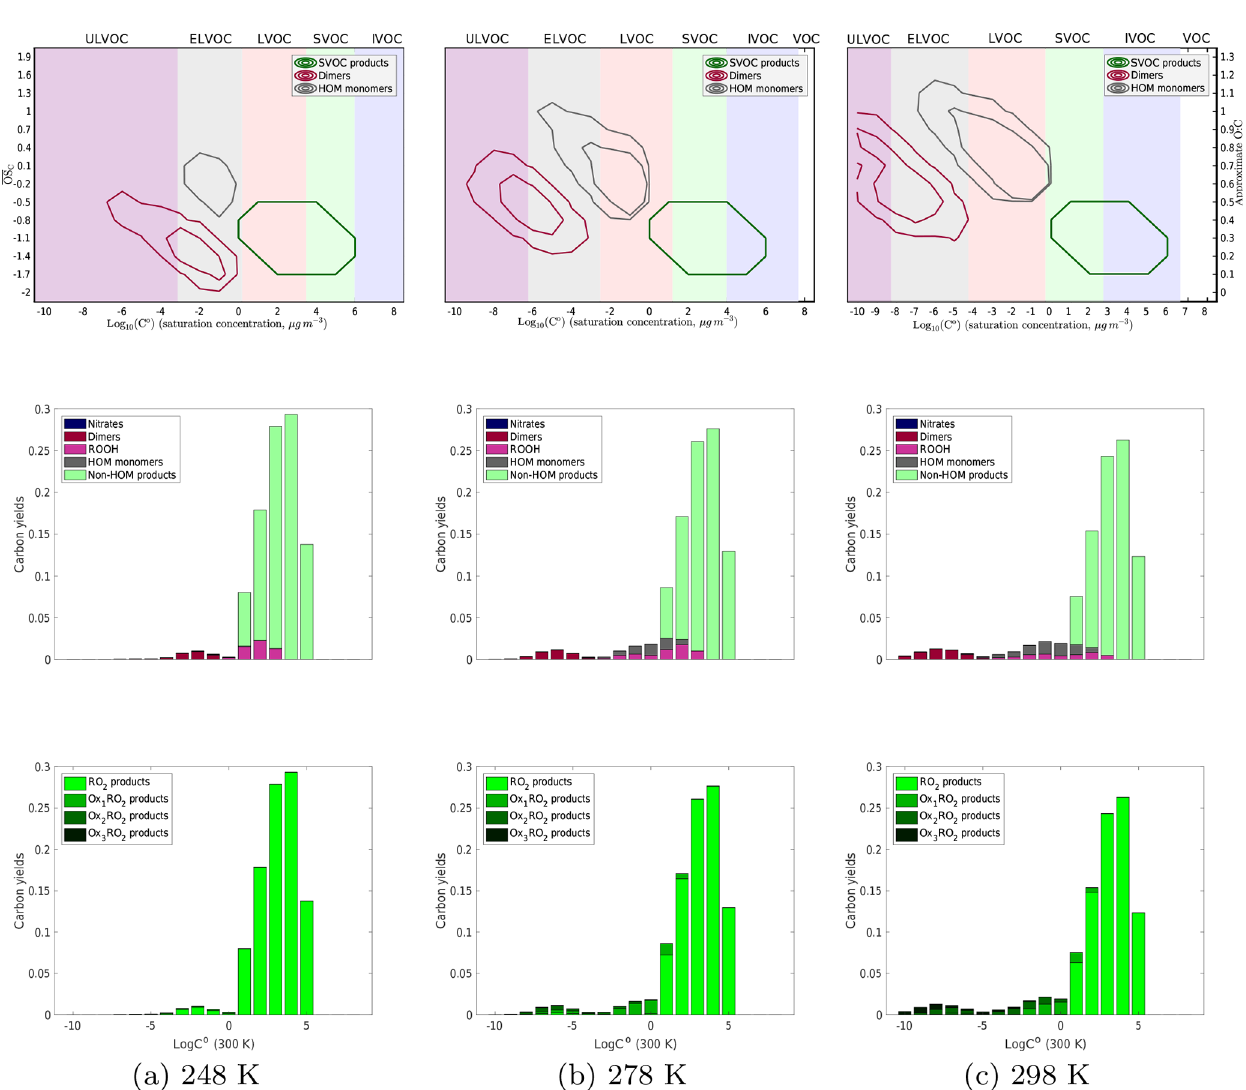
Figure 5. Yields of α -pinene oxidation products without any NO x present at 248, 278, and 298K. As temperature decreases, in the top, contour plots the dimer products shift to higher volatilities and lower O:C, even to the point where the dimers have approximately the same C ∗ (300K) as the monomer products, which is supported by experimental data. In addition, the diversity of both monomer and dimer products decreases with decreasing temperature. In the middle row of plots, where we color the yields by what type of product they are, we again see that shift of the products to higher volatilities. In addition, we see fewer dimers formed at lower temperatures. It is also of note that the formation of hydroperoxides is not a significant fraction of the yield at any temperature due to the low concentration of HO 2 . The bottom plots, colored by the extent of autoxidation the products underwent before terminating, show that as we decrease temperature, the extent of autoxidation that the peroxy radicals undergo decreases. At 248K, we see almost no products that have undergone any